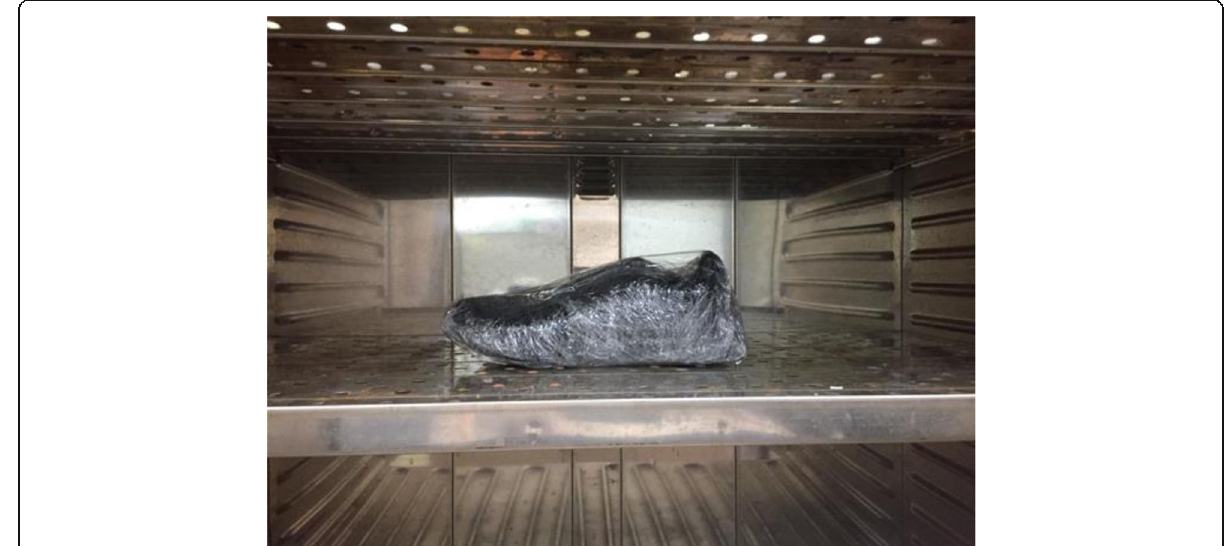
Fig. 1 Air passive sampling method of shoe odour